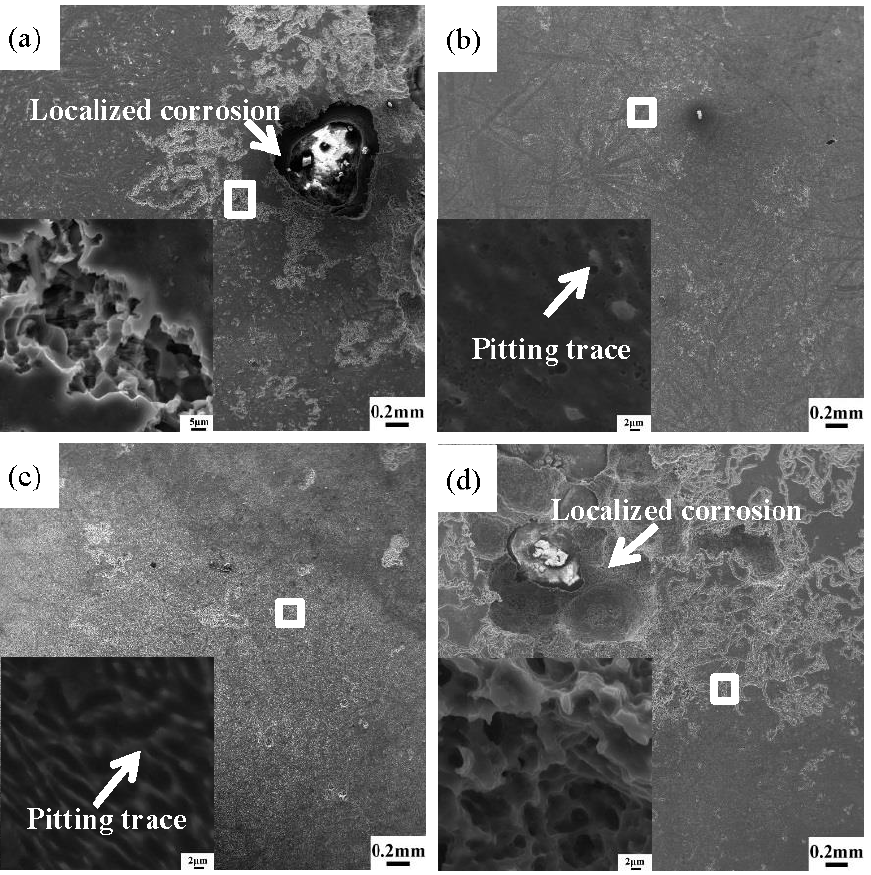
Figure 8. Corroded surface of alloys with corresponding magnified views in the insets, after seven days’ soak by SEM: Mg-1Zn ( a ), Mg-1Zn-1.0Sn ( b ), Mg-1Zn-1.5Sn ( c ) and Mg-1Zn-2.0Sn ( d